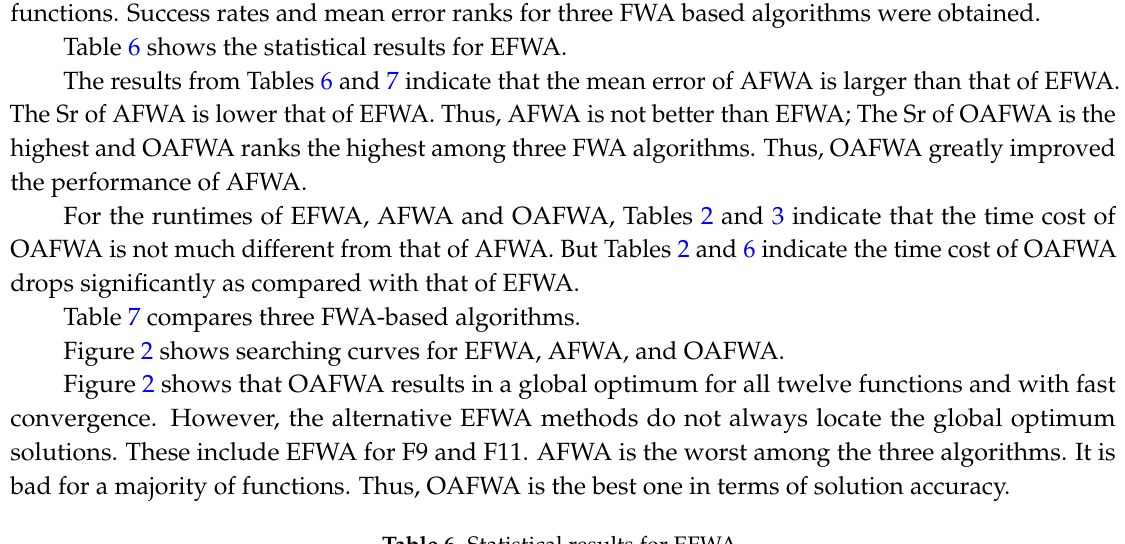
Table 6. Statistical results for